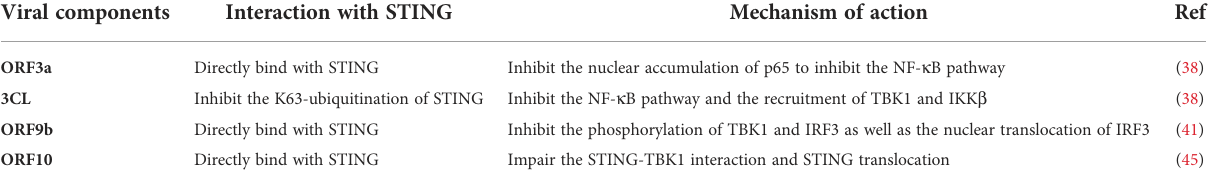
TABLE 1 The effect of SARS-CoV-2 viral components on the STING signaling pathway. Viral